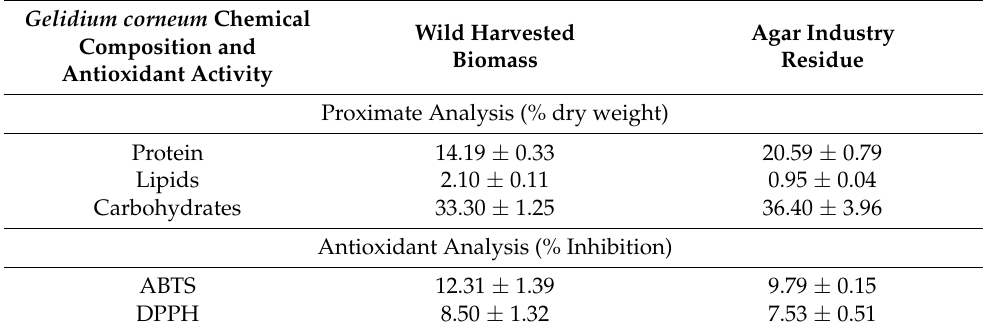
Table 3. Comparative analysis of wild-harvested and agar residue of Gelidium corneum , regarding proximate analysis and antioxidant capacity (data from [6] and personal unpublished